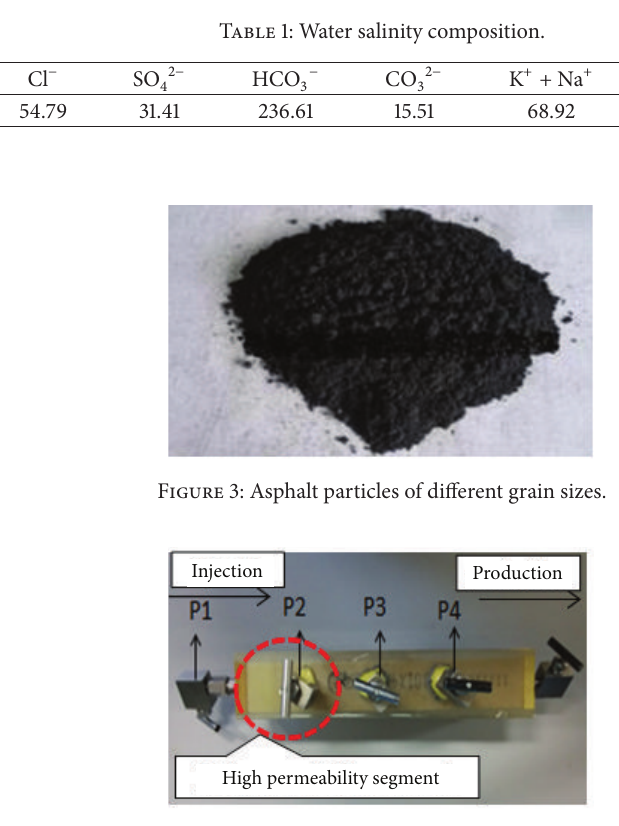
Figure 4: Diagram of man-made core and pressure